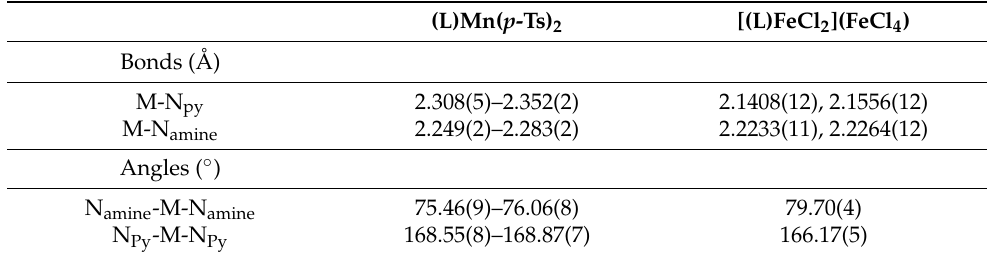
Figure 2. Molecular views of ( L )Mn( p -Ts) 2 ( a ) and [( L )FeCl 2 ](FeCl 4 ) ( b ) with the atom labelling scheme. Ellipsoids are drawn at the 50% probability level. H atoms have been omitted for the sake of clarity for ( L )Mn( p -Ts) 2 . Table 1. Selected bond distances (Å) and angles (deg.) for ( L )Mn( p -Ts) 2 and [( L )FeCl 2 ](FeCl 4